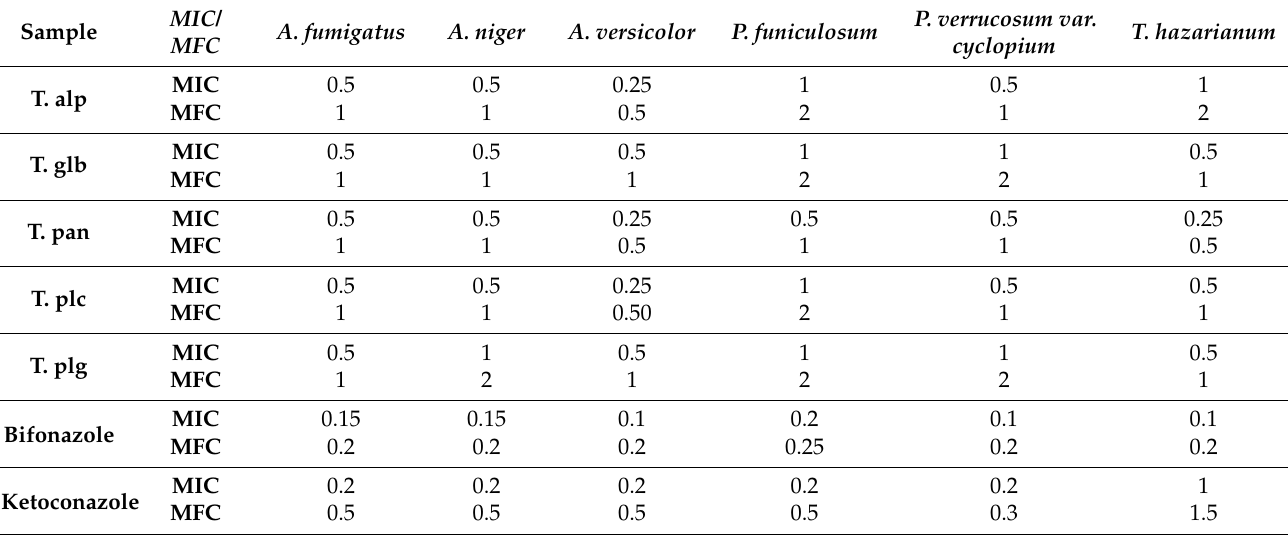
Table 5. Overview of in vitro MICs and MFCs of Thymus